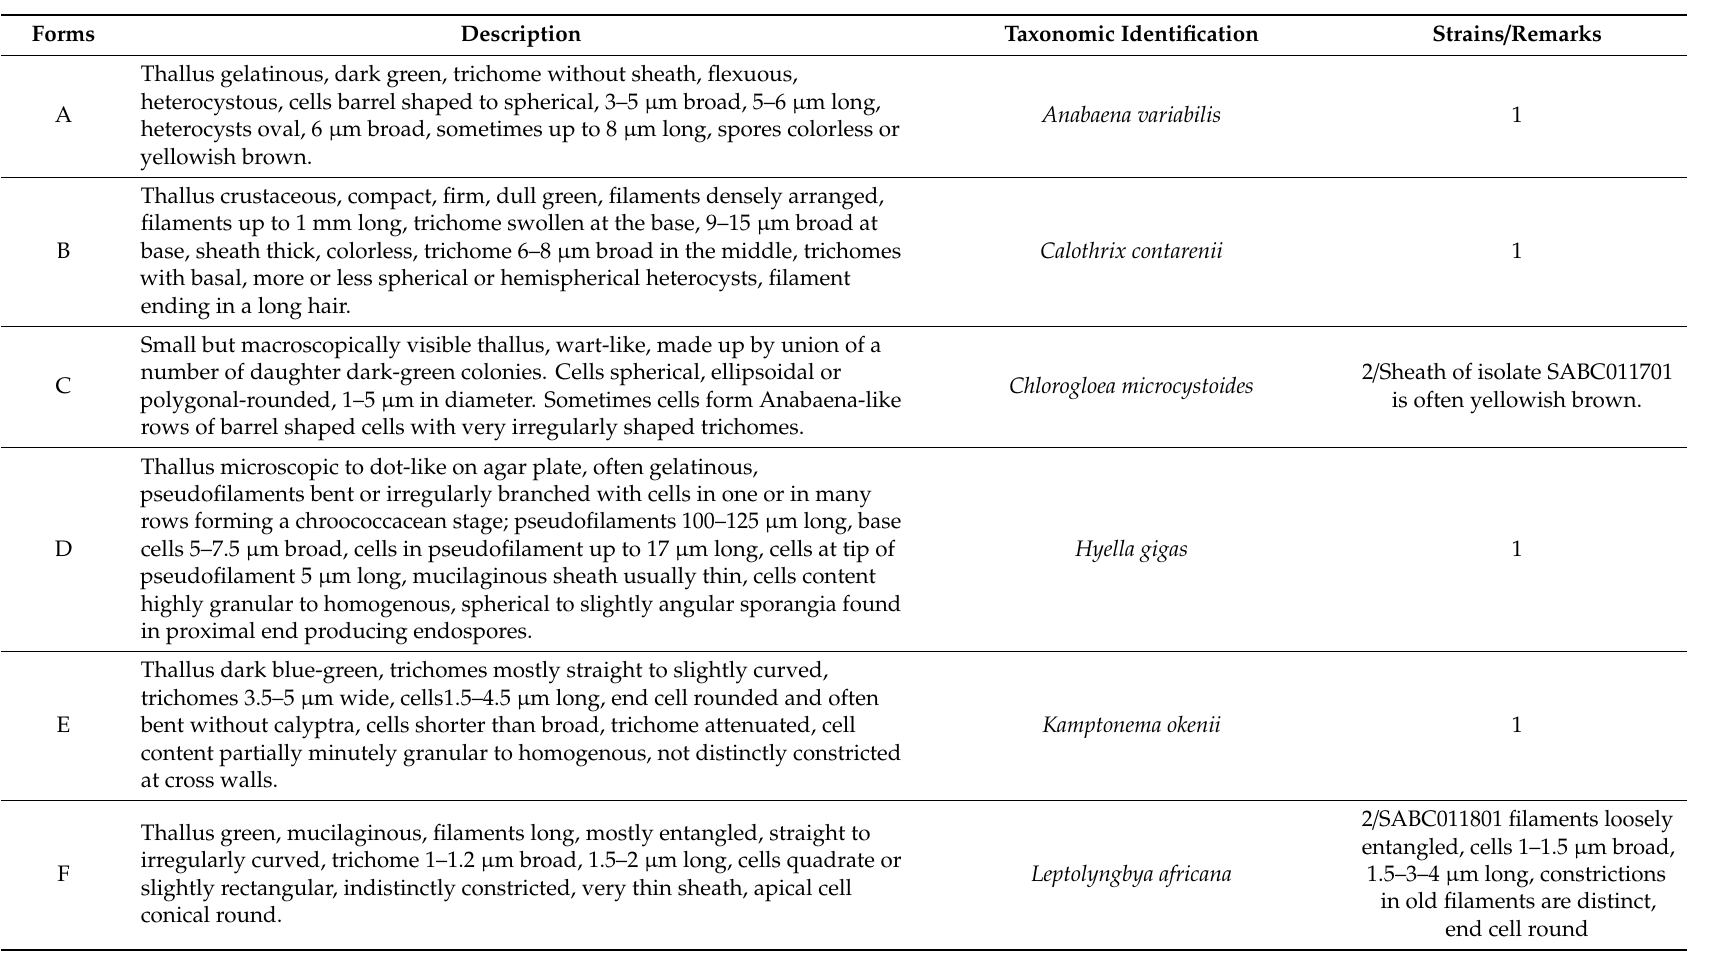
Table 3. Specific morphological descriptions of cyanobacteria